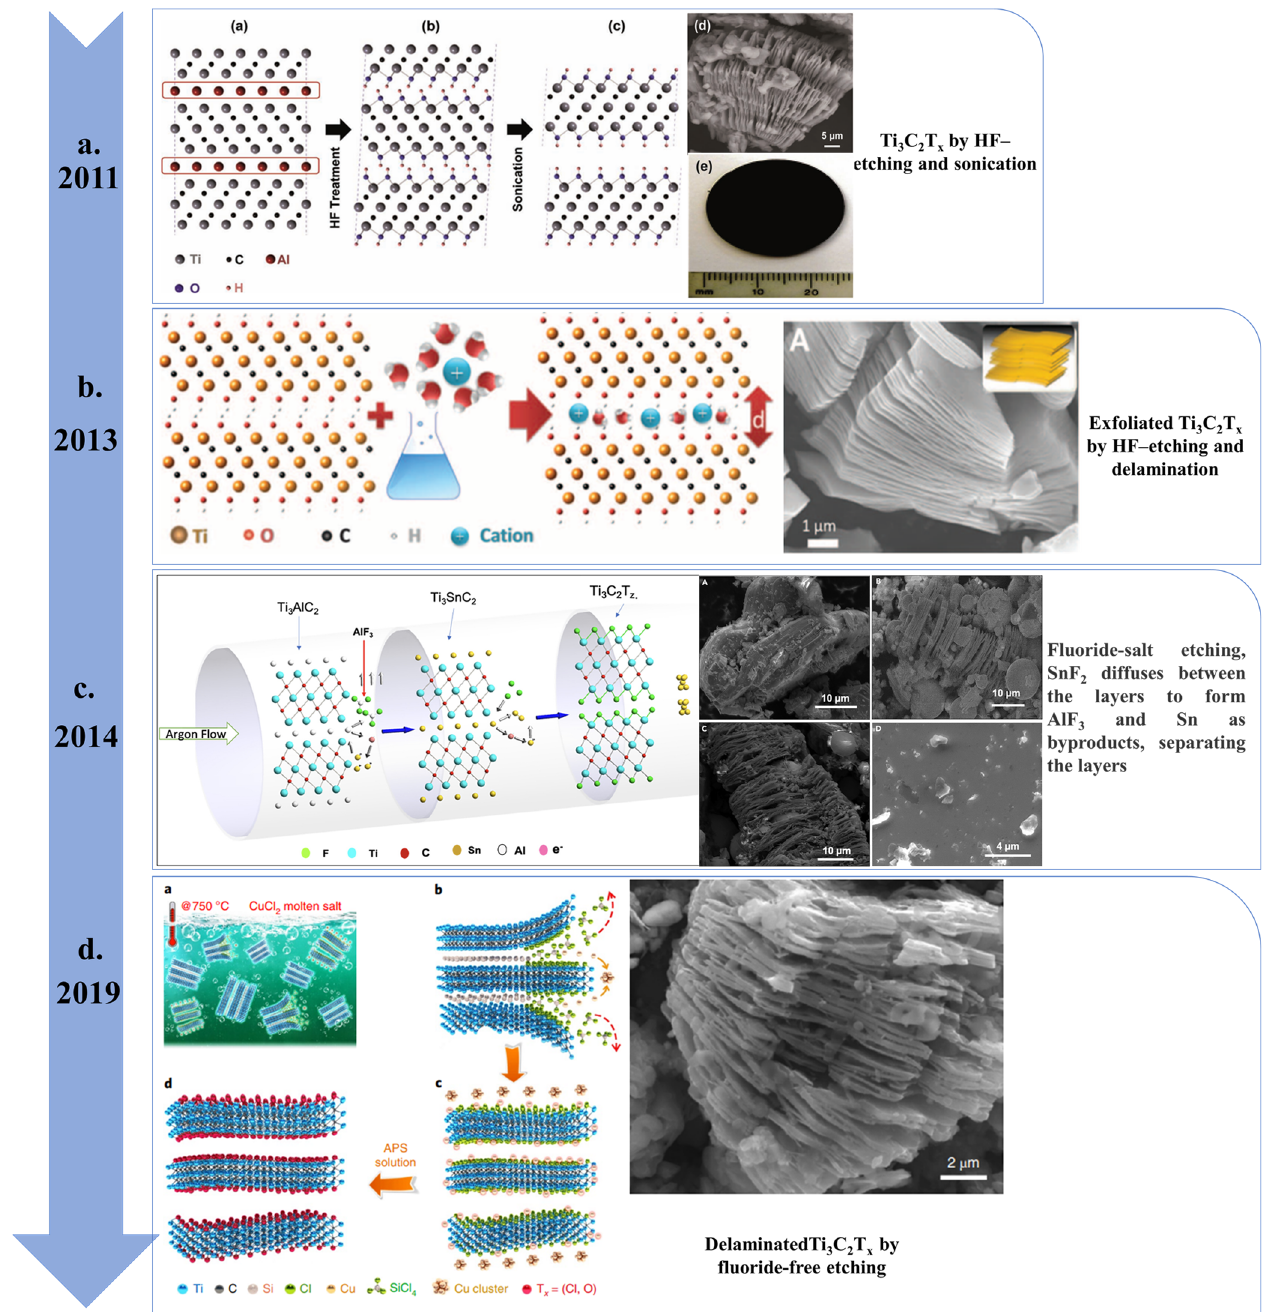
Figure 4. ( a ) Ti 3 C 2 T x -MXene [46], ( b ) MXenes-based electrode for SCs [47], ( c ) Ti 3 C 2 T x -MXene clay [45], and ( d ) Ti 3 C 2 T x -MXene by molten-salt [37]. The abovementioned etching methods were based on removing the “A” layer from MAX and forming MXene with and without surface terminations, and the lateral